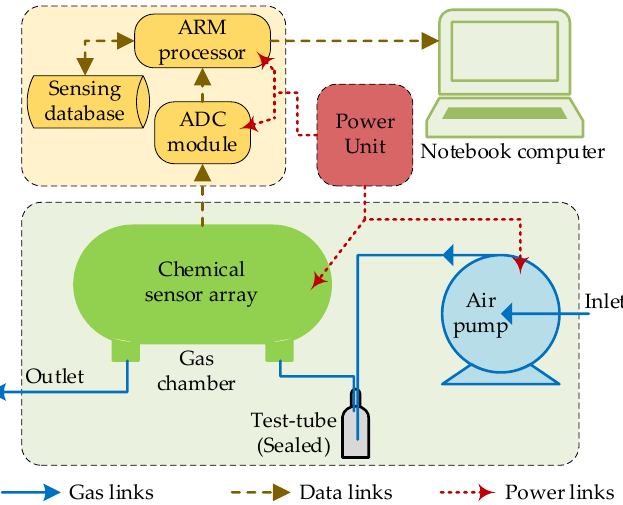
Figure 1. Structure of the EN system designed for PI experiments in the authors’ laboratory. SMU-ENOSEv1 employs a novel and simple clean mechanism. Before sampling the concentration of perfume samples, the gas chamber and collapsible bulbs must be thoroughly washed to keep the sensor surroundings clean, which is important to ensure sampling data reliability. By simply replacing the possibly contaminated test-tube with a clean test-tube, the closed chamber and collapsible tubing can be washed by pumping clean air through the gas links, as shown in Figure 1. Afterwards, the perfume samples can be dripped into the clean test-tube using a pipettor, and then volatilized and driven towards the gas chamber to activate the sampling process.